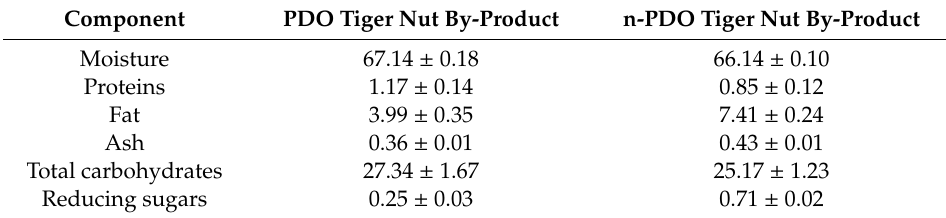
Table 1. Chemical composition tiger nut byproducts (g / 100 g fresh